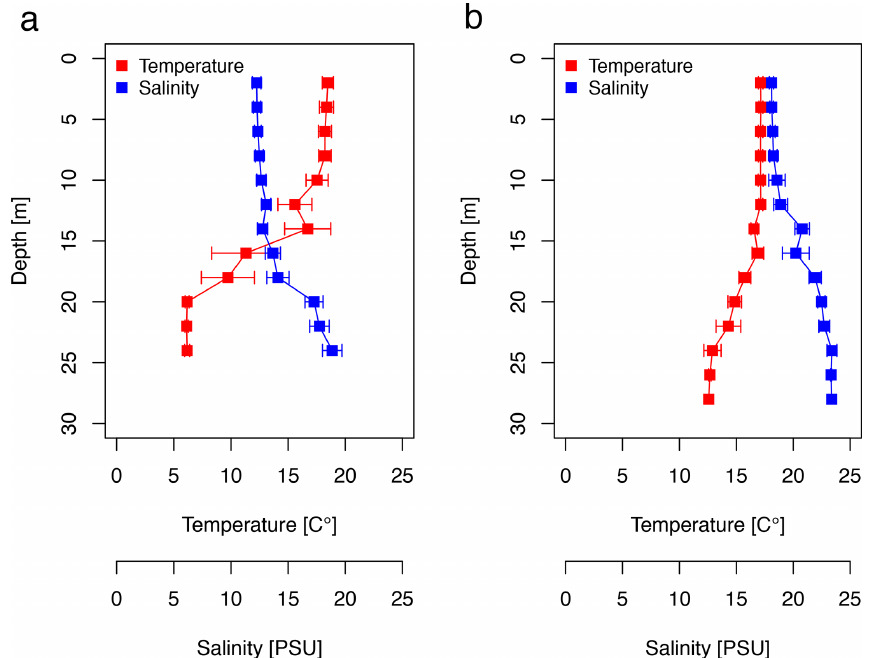
Figure 2. Temperature and salinity (CTD) profiles for (a) the June cruise (AL510) and (b) the September cruise (AL516) averaged over 2m depth